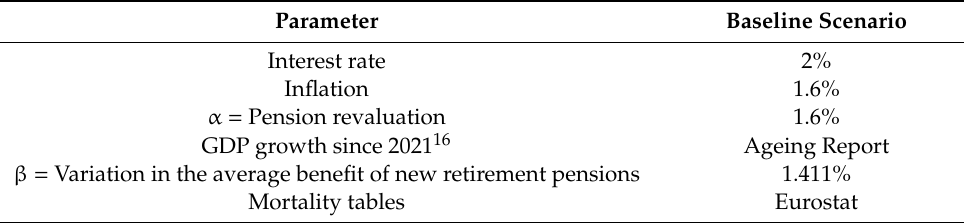
Table 4. Hypotheses adopted for the baseline scenario.